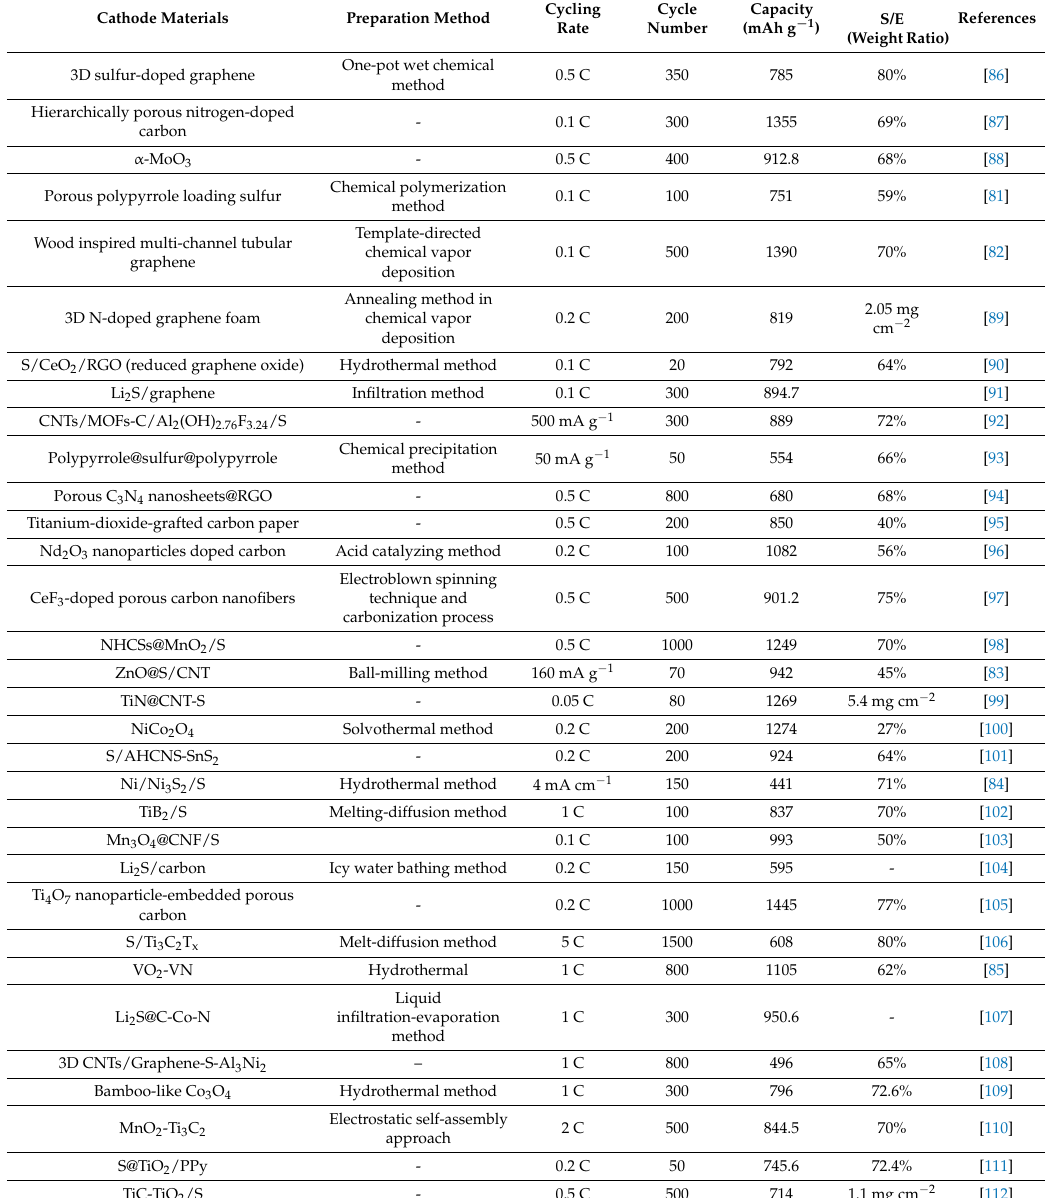
Table 2. Comparison on the performance of 3D cathodes in Li-S batteries. Cathode Materials Preparation Method 3D sulfur-doped graphene Hierarchically porous nitrogen-doped